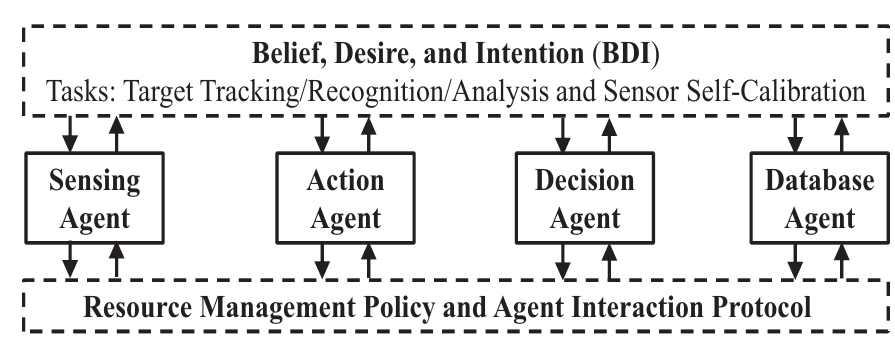
Figure 3. Illustration of multi-agent